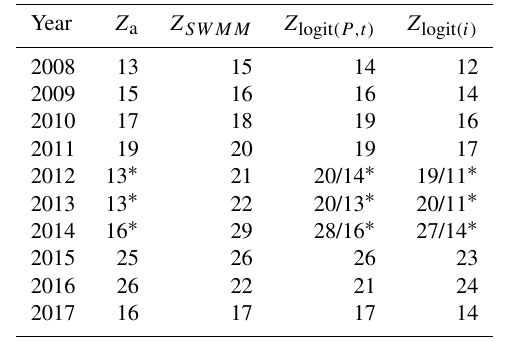
Table 1. Comparison of the measurements of the annual number of overflow events with the calculation results obtained with hydrody- namic and logit